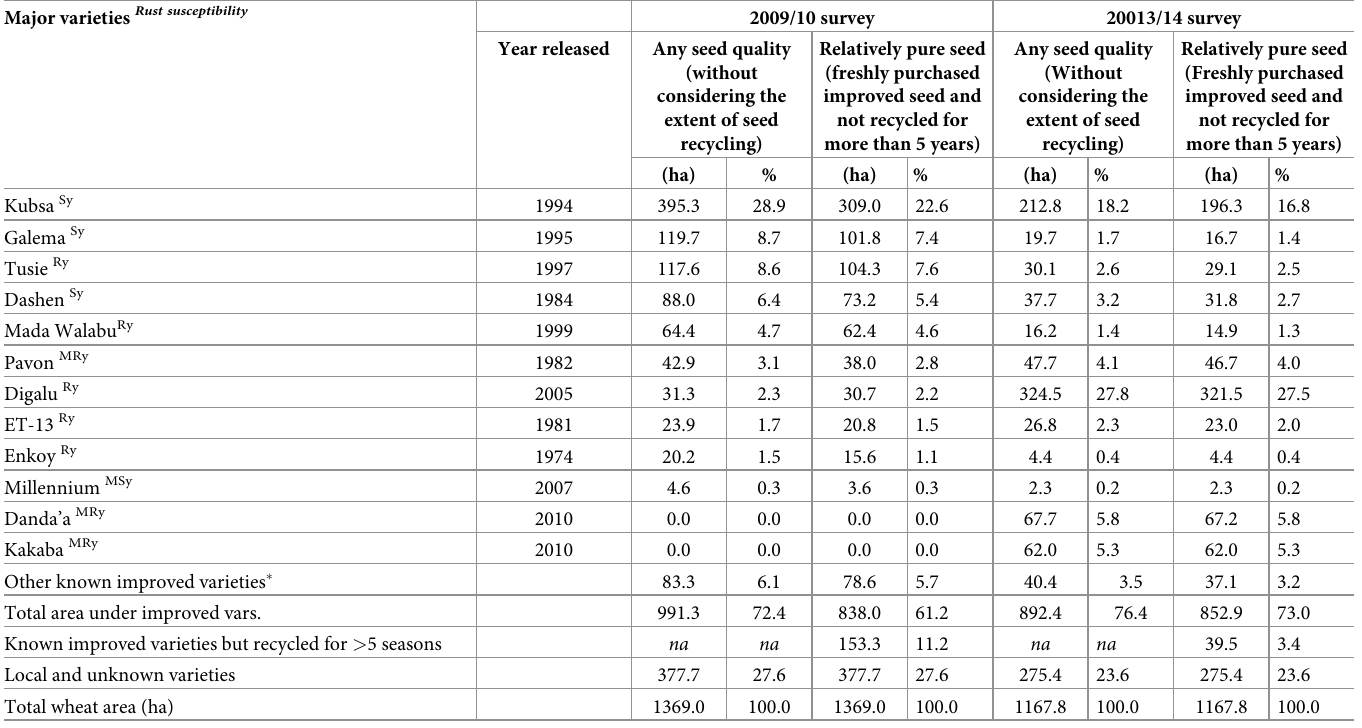
Table 2. Area share of popular improved wheat varieties from the surveyed plots,